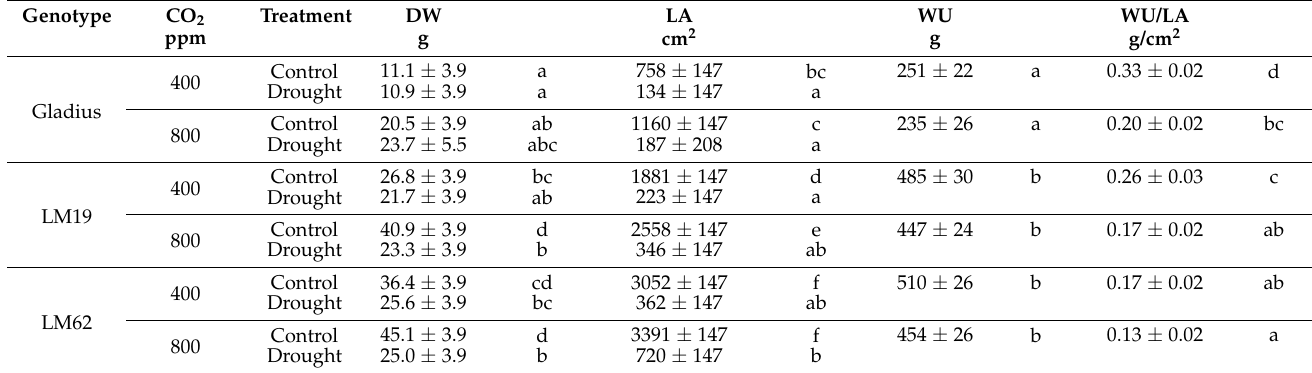
Table 2. Shoot dry matter (SDM), Leaf area (LA), from well-watered conditions (Control) and plants undergoing drought (Drought) at aCO 2 (400 ppm) or eCO 2 (800 ppm). Also, mean water use (WU) was calculated based on the daily water use of each control group during the treatment period. The mean water use per leaf area of each genotype in control conditions was calculated based on the daily water use divided by the total canopy leaf area. Values are mean ± SE ( n = 4). Values that share a letter are not significantly different according to Tukey’s honestly significant test ( p < 0.05). Values are mean ± SE ( n =